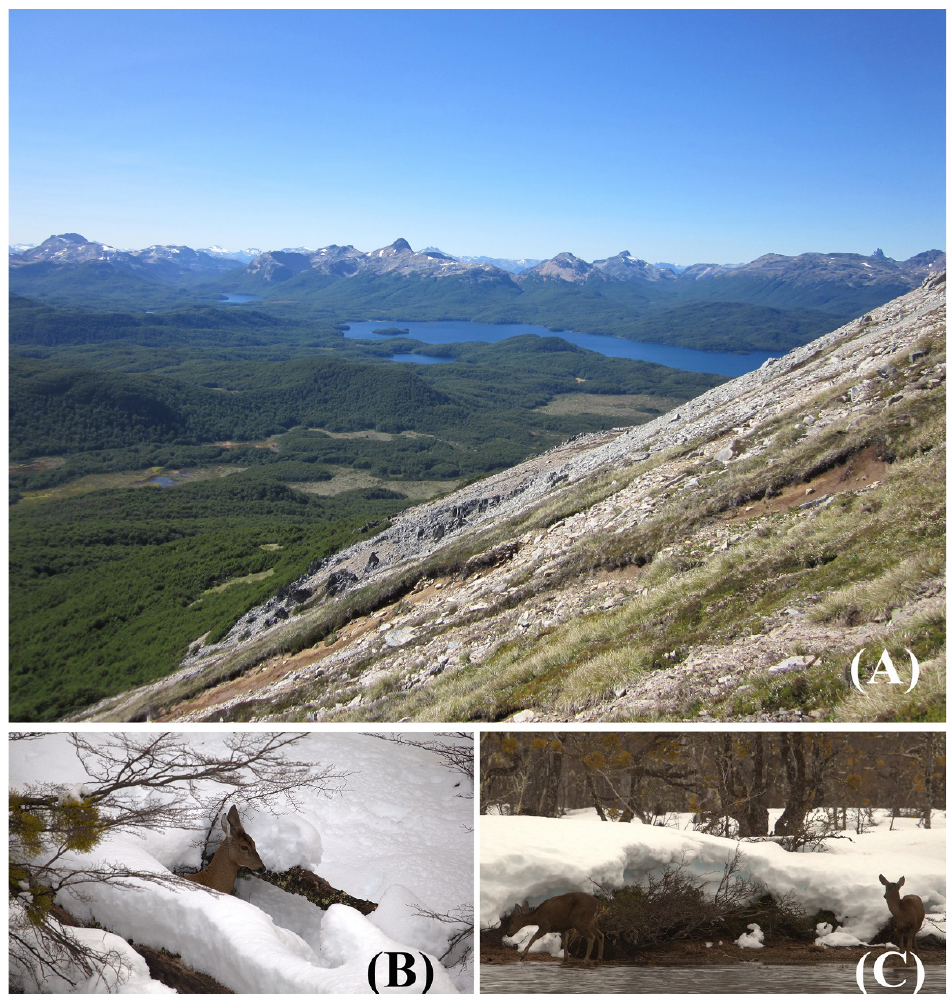
Figure 2. ( A ) Protected Park Shoonem (only its western part: 44°51′ S, 71°48′ W), owned by the village of Alto Rio Senguer, province of Chubut. The view is of the western portion of Lake La Plata, with the surrounding mountains physically defining the watershed of the river Senguer and serving as a refuge area for huemul. The edge of the lake provides the lowest elevation accessed by huemul during winter, ( B ) snow conditions frequently result in huemul using open water for their displacements, ( C ) photos taken in September 2017.